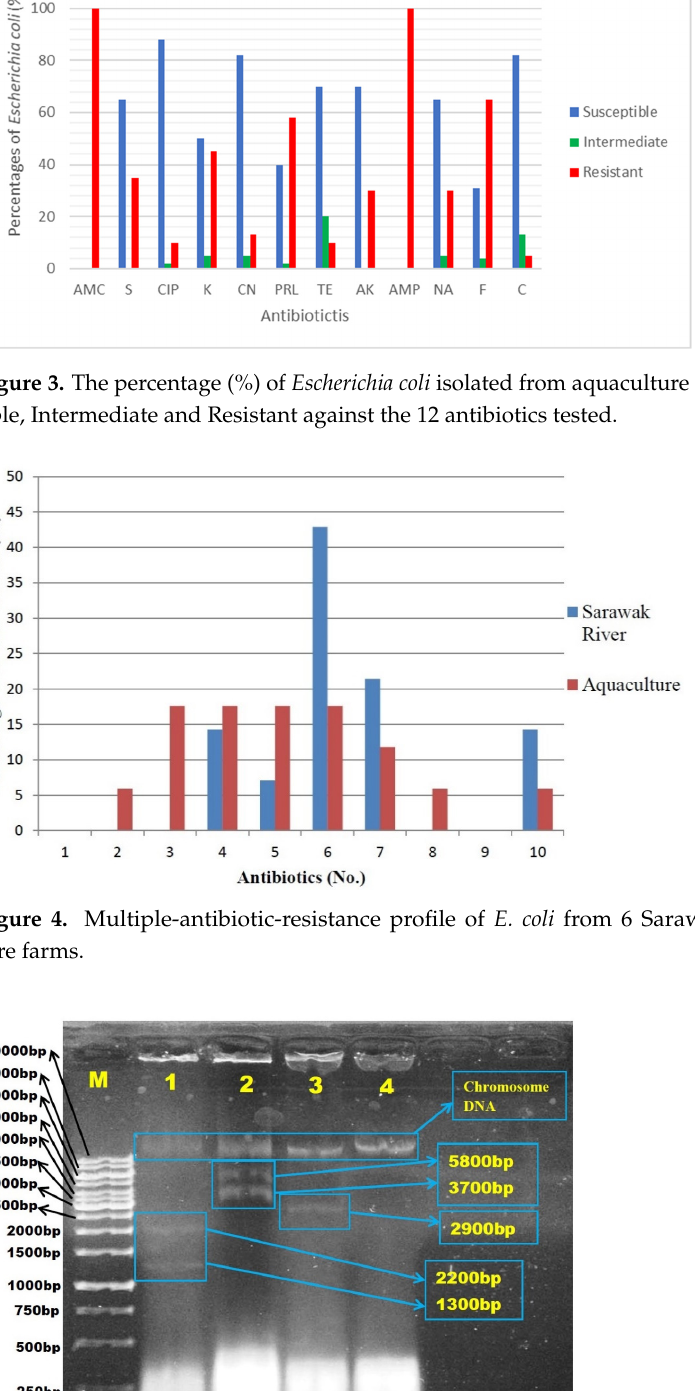
Figure 5. Agarose gel electrophoresis photograph of the estimated molecular weight size (kb) of the plasmid fragments in Escherichia coli isolated from Sarawak rivers and aquaculture farms. The estimated plasmid size was measured by comparing their band patterns obtained in agarose gel with linear DNA markers. Lane M, 1kb ladder; Lane 1, E. coli ATCC 25922; Lane 2, WF-S2B; Lane 3, WF-S3B, Lane 4, BT-S3.